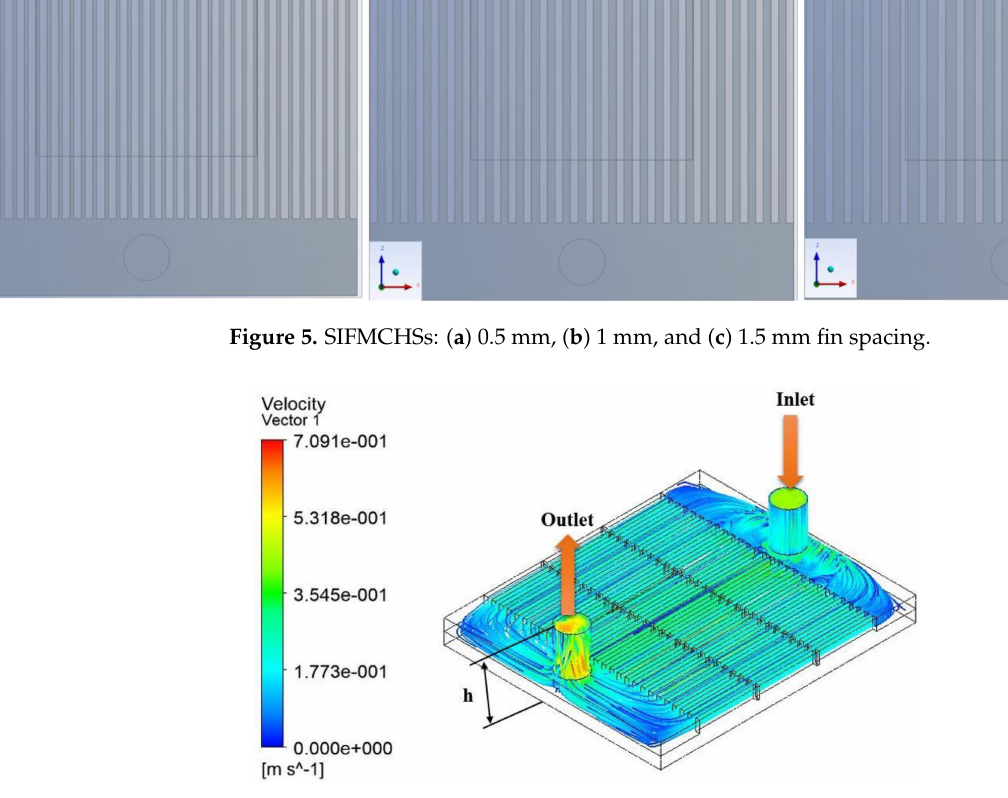
Figure 6. Propagation of flow through two SPFMCHSs.